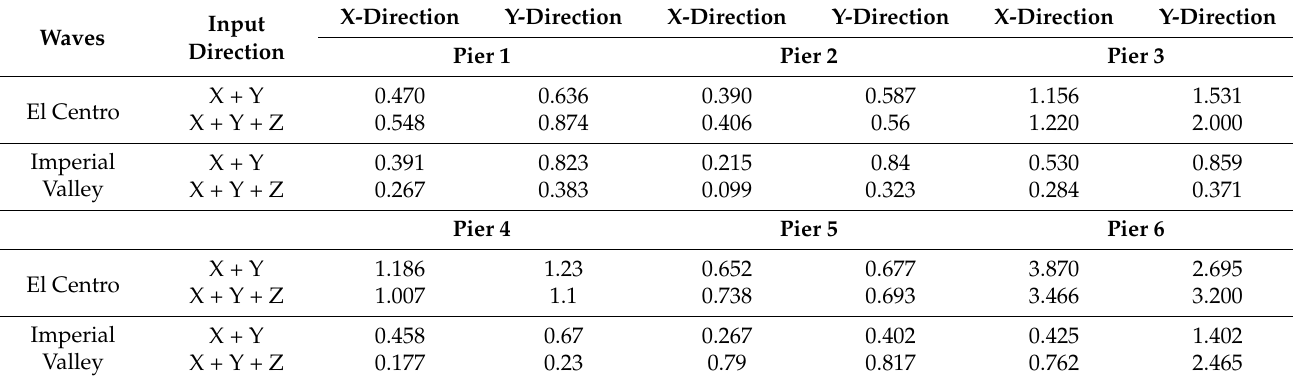
Table 5. Peak acceleration response of the pier top under multidirectional excitation ( g